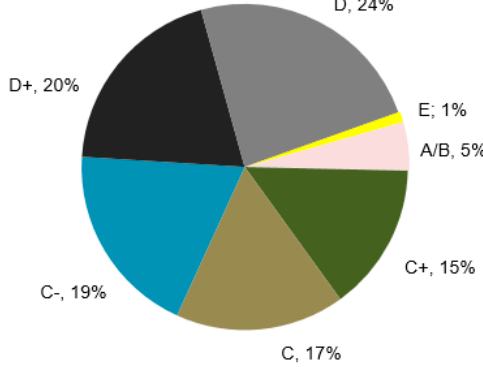
Figure 2. The socio-economic level of the 1000 people surveyed (in percent), 2018. Source: Own elaboration based on the results obtained from a national survey (2018). * Percentages do not add up to 100% due to the rounding of figures.